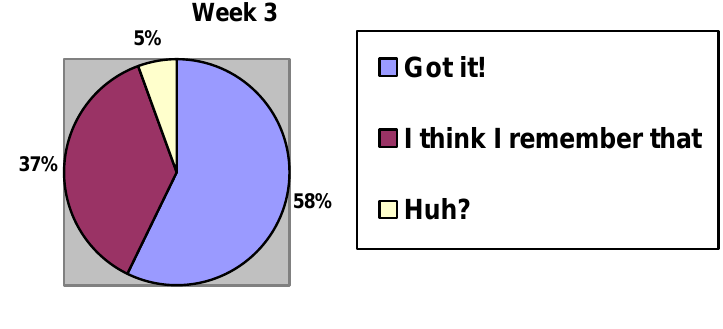
Figure 10. Student Comprehension Checklist compiled during the third week of the implementation of posting and communicating daily learning objectives.